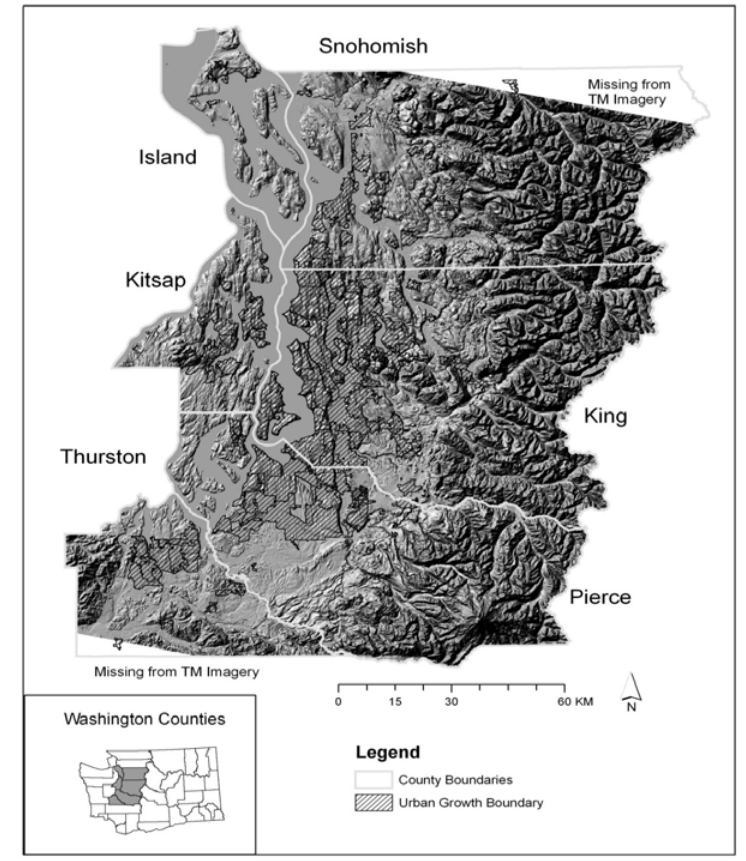
Figure 1. Six county study area in western Washington, USA showing the 2002 Urban Growth Areas, elevation, water, and county